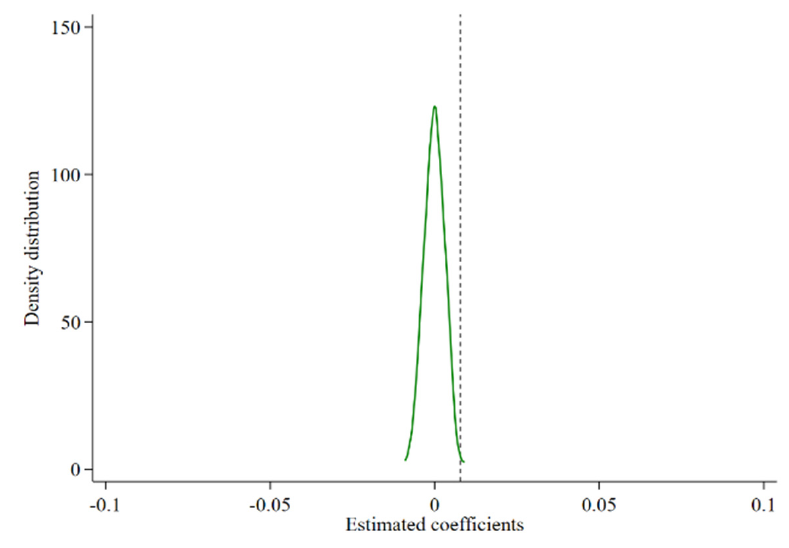
Figure 3. Placebo test results.